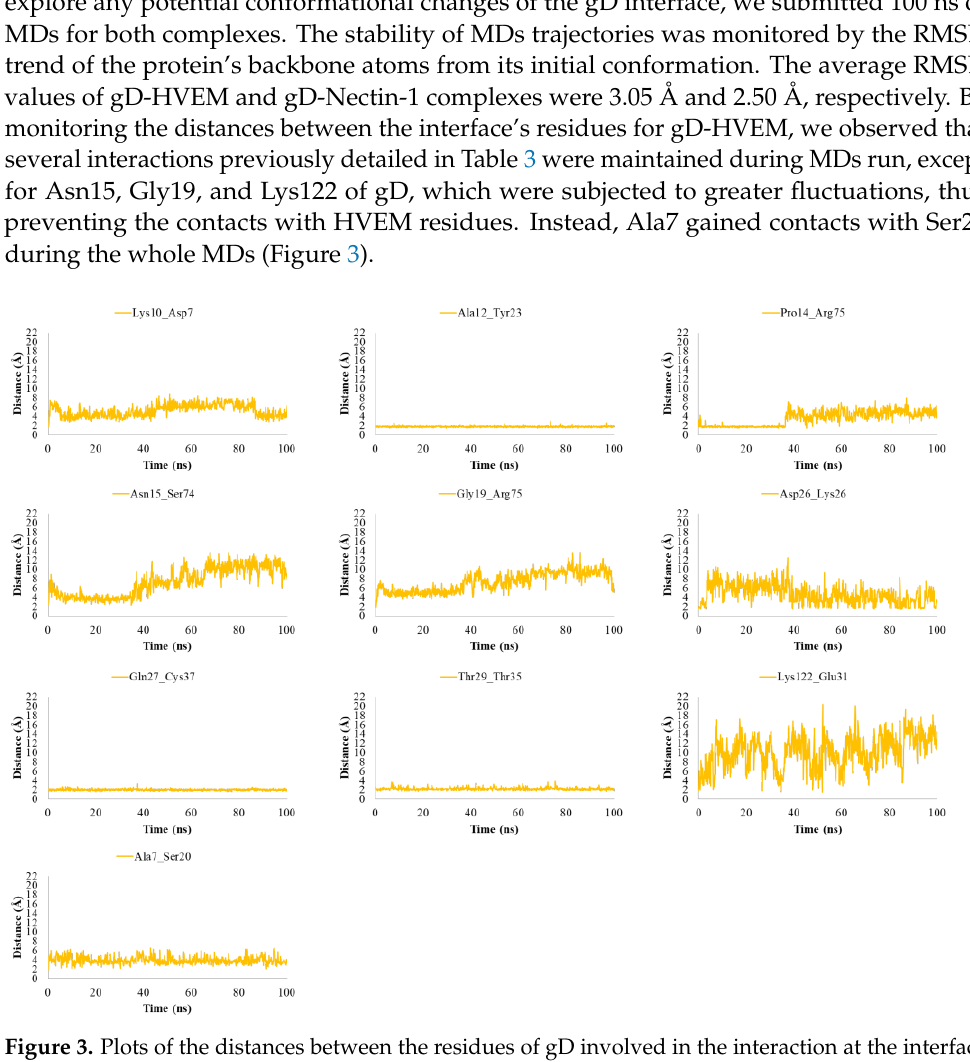
Figure 3. Plots of the distances between the residues of gD involved in the interaction at the interface with HVEM after 100 ns of MDs.